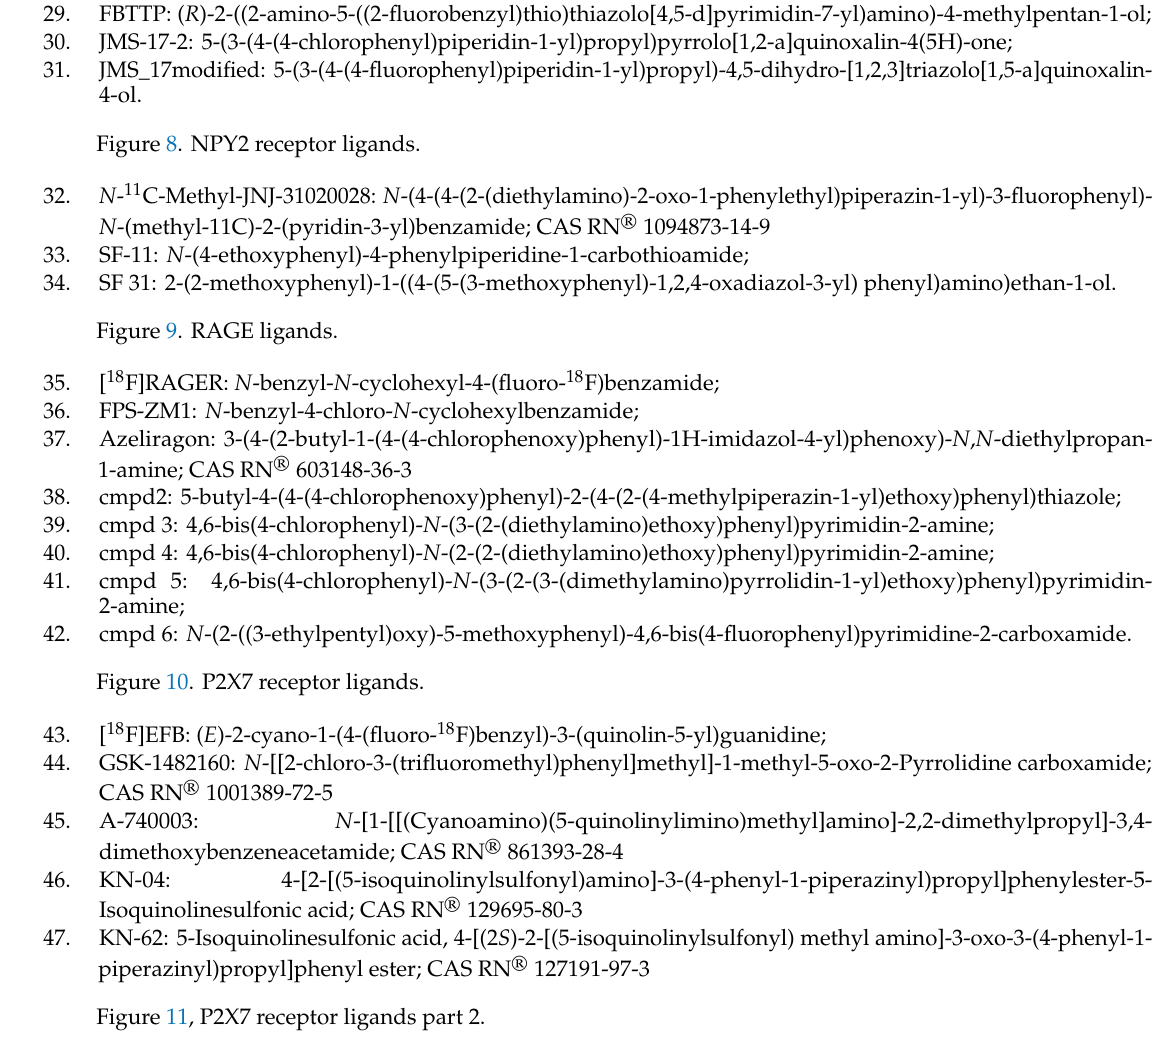
Figure 7. Antagonists at CX3CR1 and allosteric modulators.